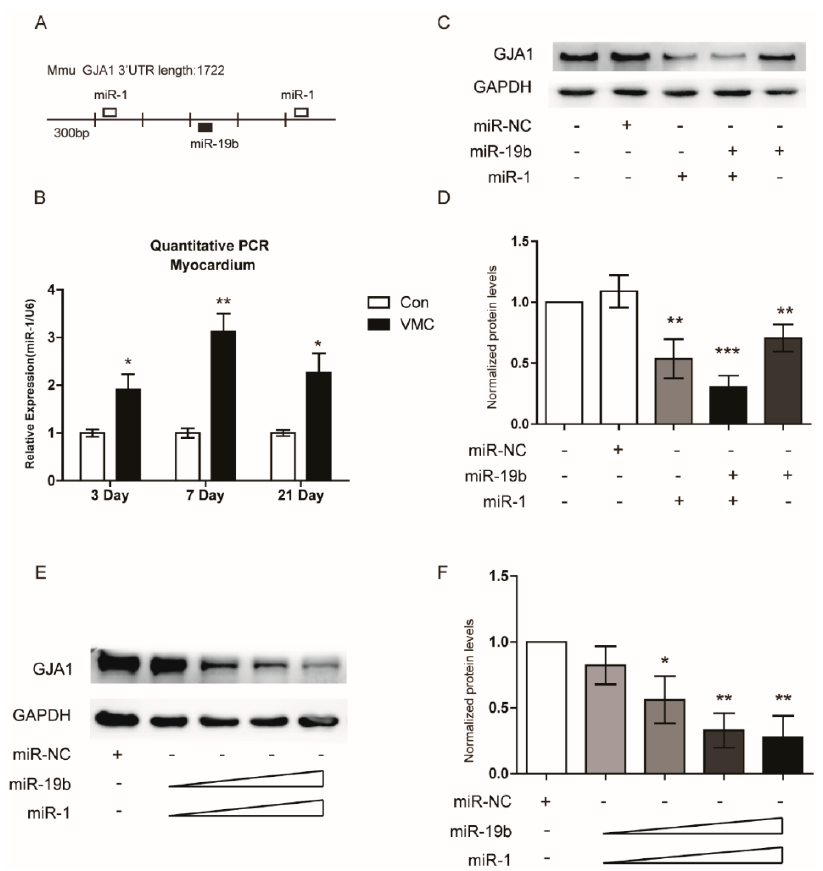
Figure 5. miR-19b and miR-1 cooperated to inhibit the GJA1 expression in HL-1 cells and hiPSC-CMs. ( A ) Bioinformatics analysis predicted the possible target sites of miR-19b and miR-1 in the 3’ UTR of GJA1; ( B ) qRT-PCR revealed miR-1 was increased at the indicated time of VMC mice model. n = 6 per group; ( C , D ) miR-19b and miR-1 mimics (50 nM) were transfected into HL-1 cells individually or in combination. The according changes of GJA1 levels were examined by western blot; ( E , F ) Various doses of miR-19b and miR-1 mimics (25, 50, 75, 100 nM) were cotransfected in combination into hiPSC-CMs. GJA1 protein levels were analyzed by western blot. n = 3 per group. * p < 0.05, ** p < 0.01 *** p < 0.001 vs . negative control.